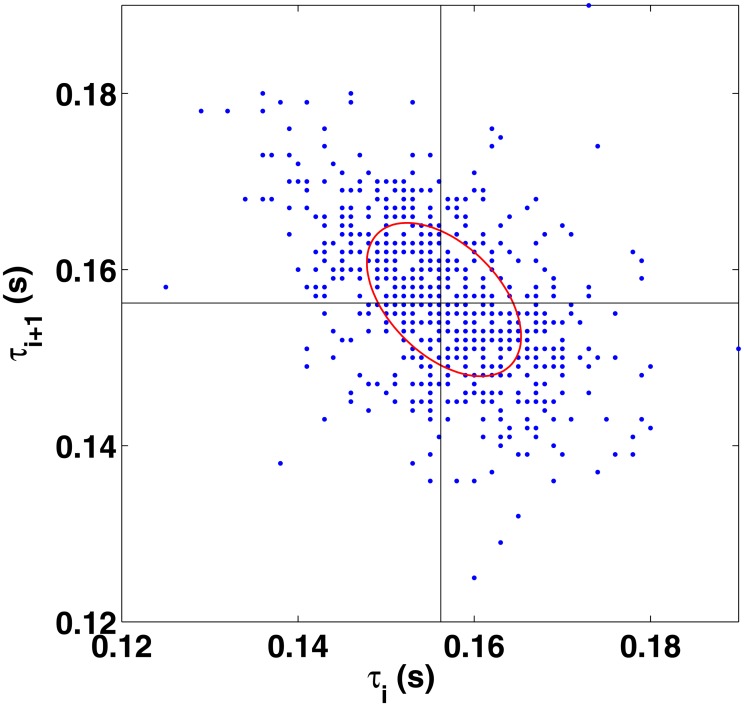
Poincaré plot (return map) of the interbeat intervals that map the i:th interval to the following one.The data shows negative correlations with Pearson coefficient −0.48.